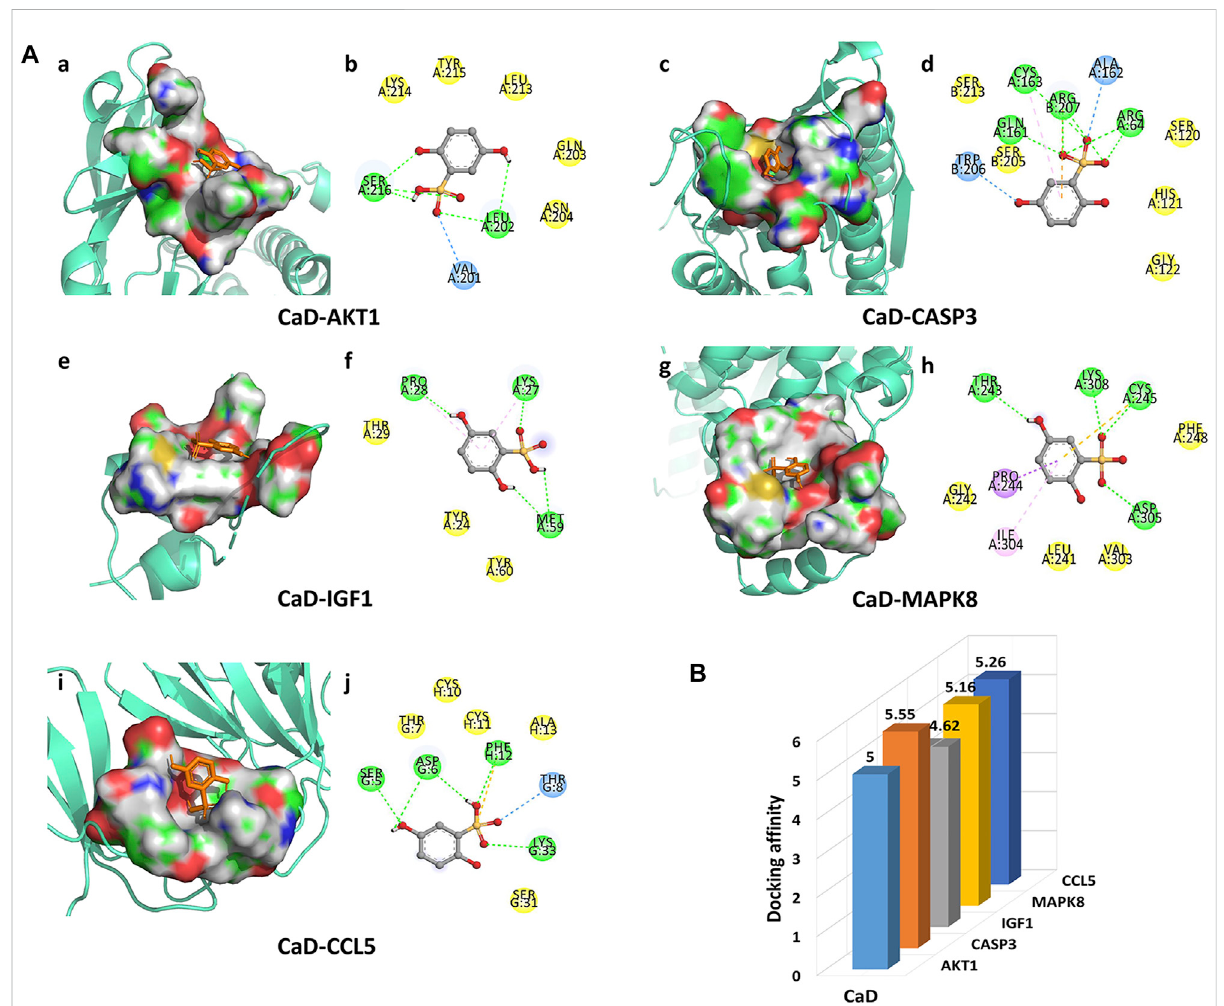
FIGURE 6 Moleculardockingdiagram. (A) Fiveconformationsofamoleculardockingsimulation.Diagrams(3D)representthatthemolecularmodelofthe compoundisinthebindingpocketoftheprotein.Thecompoundisshownasastickmodelinorange.Theaminoacidresiduesinthesurroundingare represented by surface style.Diagrams (2D) show the interactions betweenthecompound and surroundingresidues. (B) 3Dcolumndiagram shows the af fi nity of six conformations. X -axis: bioactive component, y -axis: target names, and z -axis: docking af fi nity (absolute value of the binding